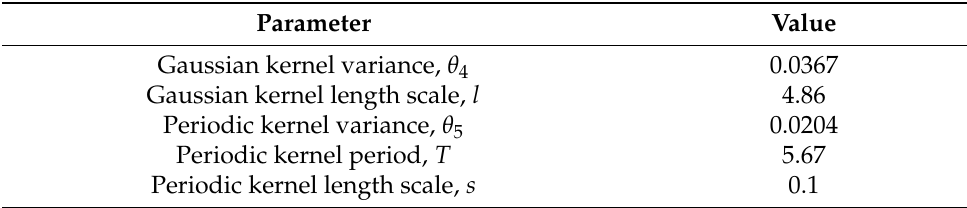
Table 2. The optimal kernel parameters for the tested Gaussian kernel with periodical kernels.